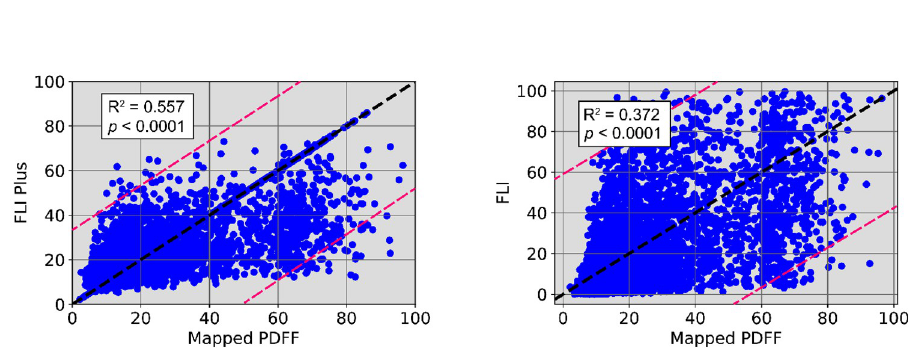
Four-fold cross-validation (CV) results of mean absolute error (MAE), standard deviation (SD) and coefficient of determination (R 2 ) of fatty liver index (FLI)+ and FLI when compared to mapped proton density fat fraction (PDFF) interpolated to FLI range and threshold.